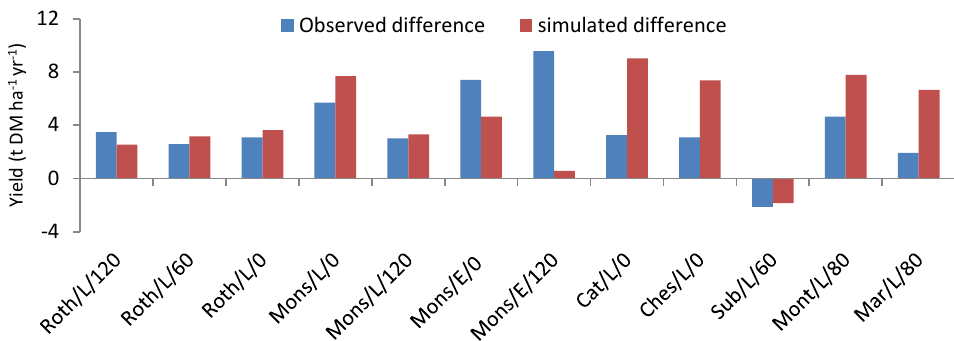
Figure 6. Histogram of differences between miscanthus and switchgrass annual yields, as observed (blue bars) or simulated by CERES-EGC (red bars) across the different experimental sites Rothamsted (Roth), Estrée-Mons (Mons), Catenoy (cat), Chesnoy (CHes), Subdray (Sub), Montant (Mont) and Marchais (Mar). For each region the difference is calculated for each cut (late (L) and early (E)), and each fertilization level (0, 60, 80 or 120 kg N ha − 1 yr − 1 ).